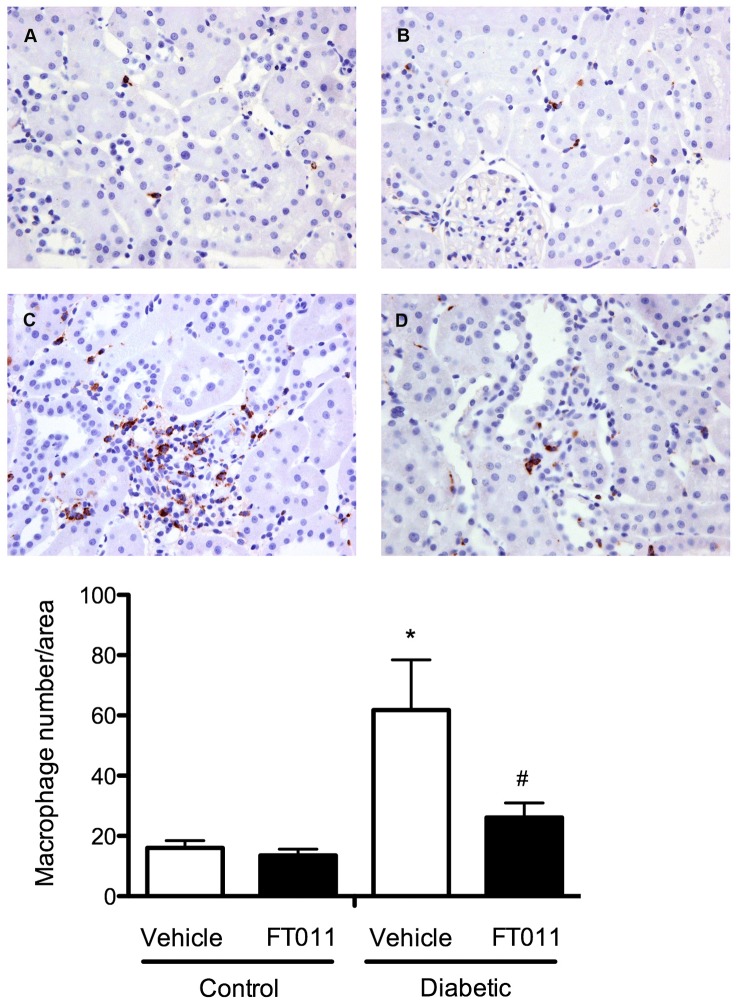
Representative photomicrograph of ED-1 staining from diabetic rats.Representative photomicrographs of ED-1 immunostained sections from control and diabetic rats treated with or without FT011. In control (A) and control treated with FT011 (B) rats, only occasional macrophages were observed in the interstitium, while diabetic rats (C) were associated with numerous macrophages. Treatment of diabetic animals with FT011 (D) was associated with a reduction in macrophage number. Magnification x200. Quantitative data are expressed as mean ± SEM. *P<0.05 versus control; #
P<0.05 versus vehicle treated diabetic rats.